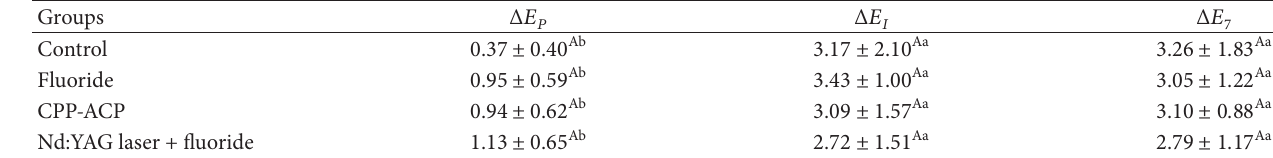
Table 4: Means and standard deviations for the Δ𝐸